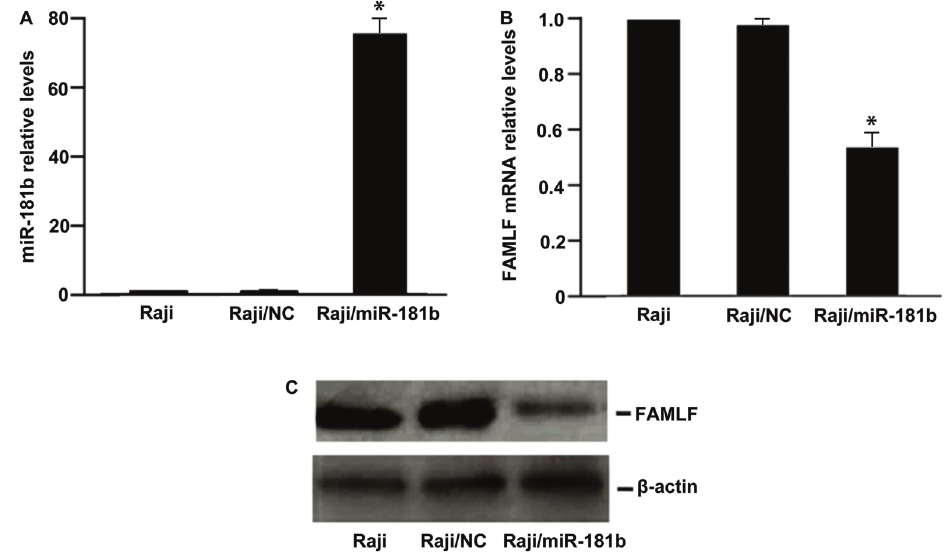
Figure 3. Detection of miR-181b transfection ef fi ciency and FAMLF expression in Raji cells. A , miR-181b expression was increased 75 times after transfection. B , FAMLF mRNA expression was reduced by half after transfection. C , FAMLF protein was reduced by approximately 20% after transfection. Raji group was used as the control (NC) and was normalized. Data are reported as means ± SD (n=6). *P o 0.01, Raji/miR-181b compared to Raji and Raji/NC (ANOVA).